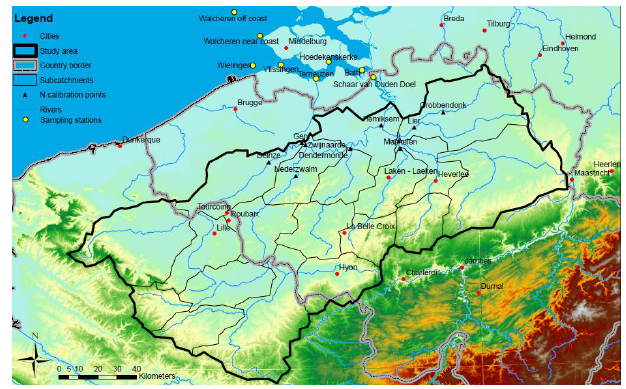
Fig. 2. Scheldt catchment and its tributaries, as well as the locations of stations used for verification (Figs. 3 and 4). The station Hemiksem forms the transition from river to